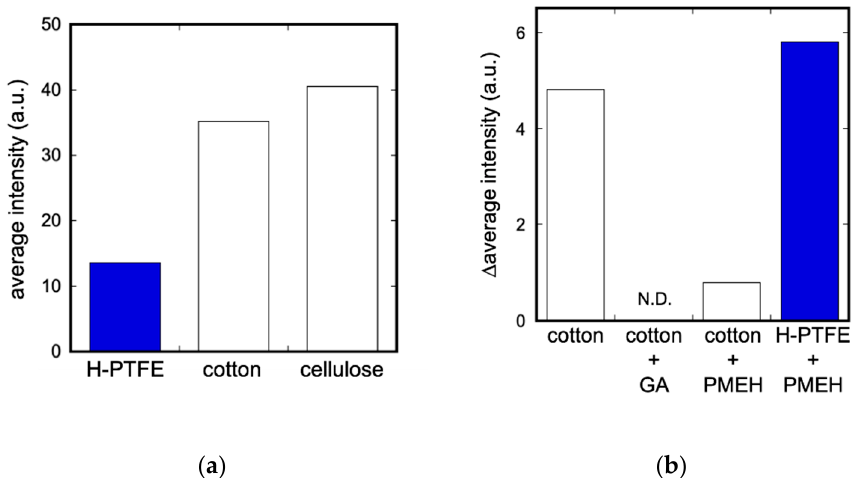
Figure 2. Evaluation and selection of enzyme immobilization substrates and immobilization materials. ( a ) Comparison of intrinsic fluorescence of the H-PTFE membrane, cotton mesh substrate, and cellulose membrane. ( b ) Comparison of the average intensity of combinations of substrates (cotton, PMEH) and immobilization methods (glutaraldehyde, PMEH polymer) to 1.0 ppm acetone gas. (a.u., arbitrary unit; GA, glutaraldehyde; H-PTFE, hydrophilic polytetrafluoroethylene; PMEH, 2-methacryloyloxyethyl phosphorylcholine and 2-ethylhexyl methacrylate).